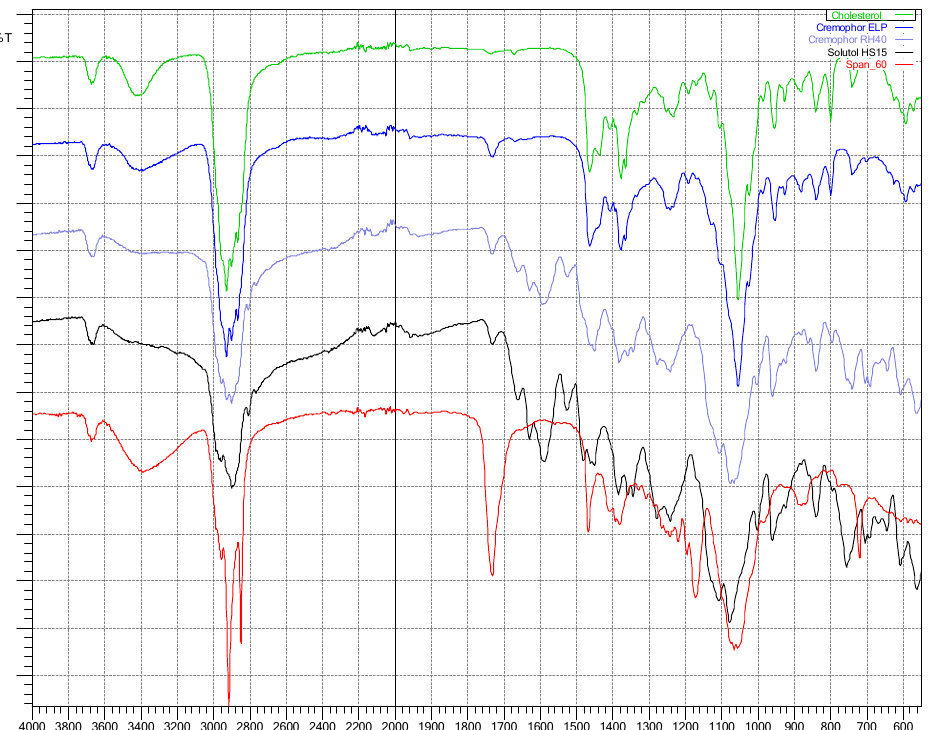
Figure 4. FTIR spectra taken for individual ingredient: cholesterol (green), Cremophor® ELP (blue),